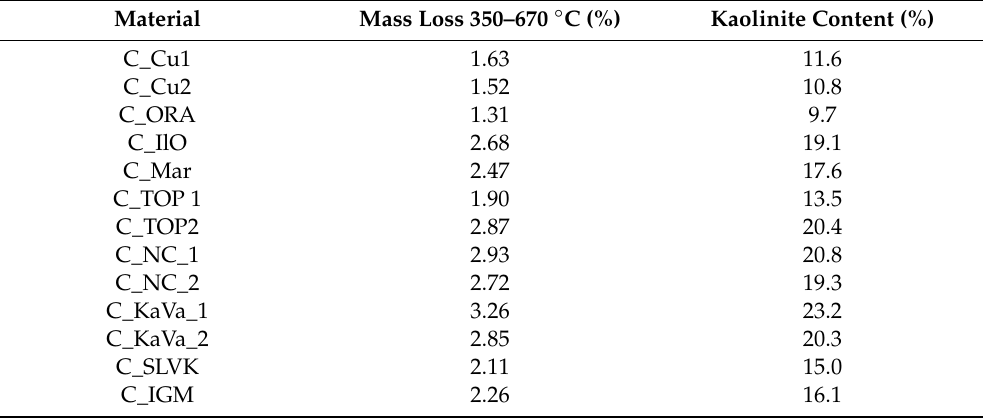
Table 3. Mass loss and mineral content calculation obtained by TGA for di ff erent clays.